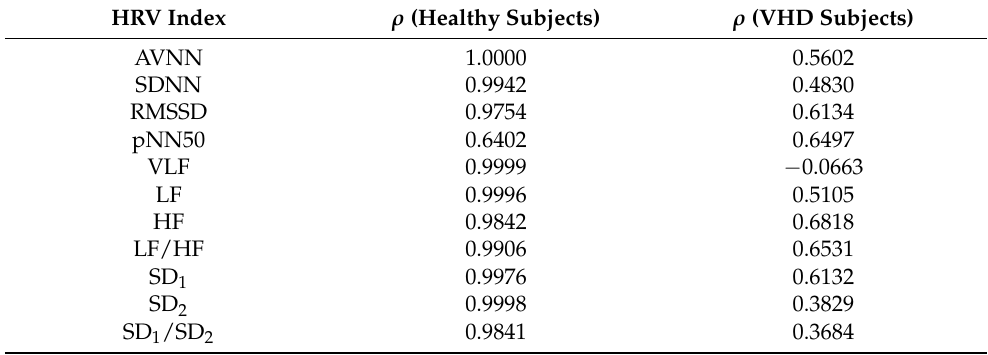
Table 7. Pearson’s linear correlation coefficient of HRV indices obtained from ECG and GCG